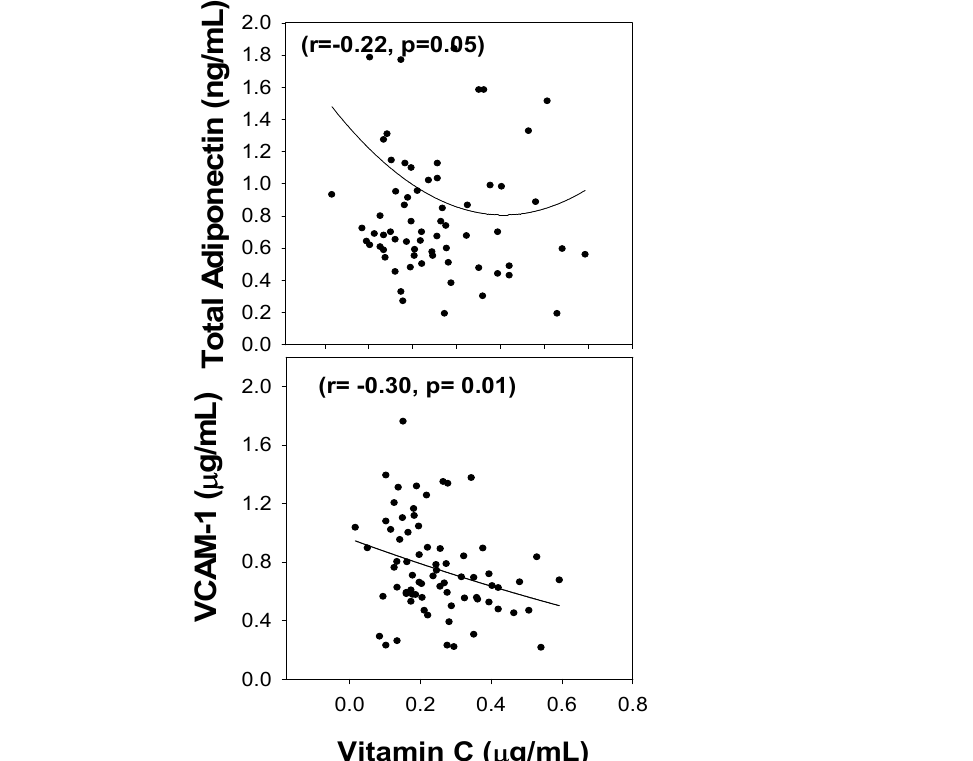
with with diabetes.